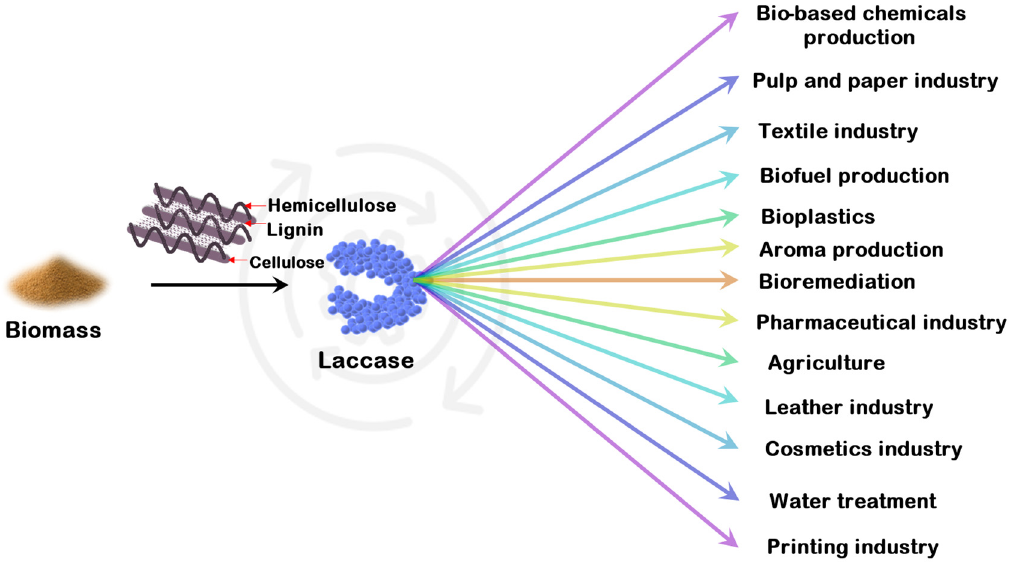
Figure 2. Figure showing the application of laccases in different industries and bioprocesses.